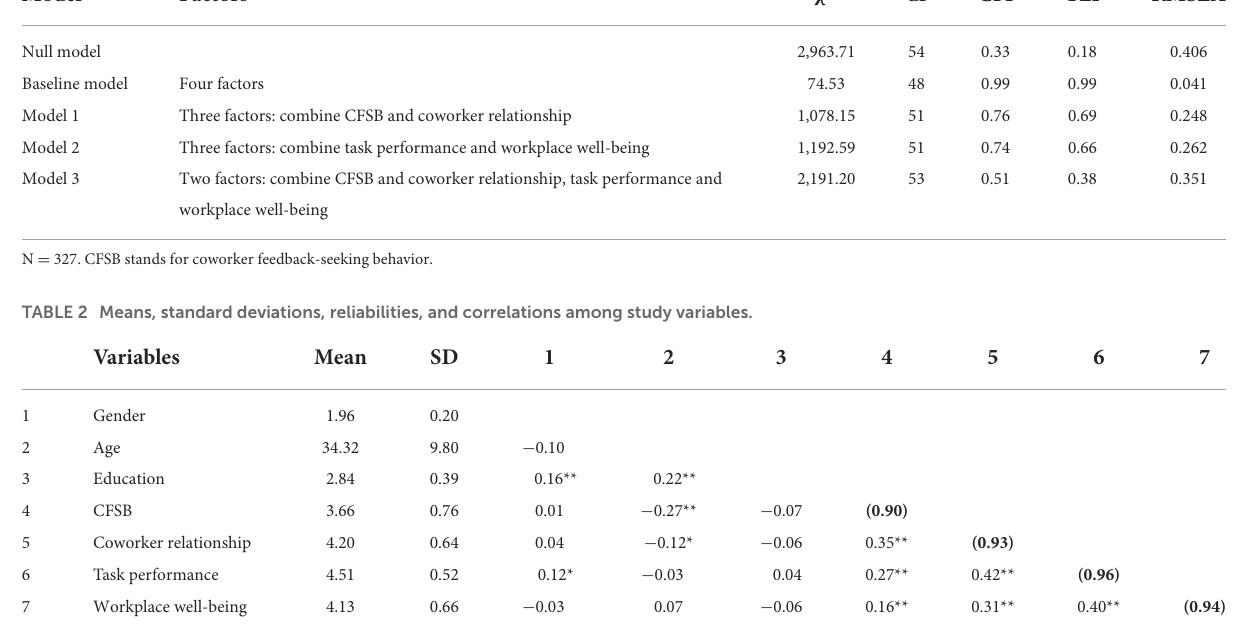
TABLE 1 Results of confirmatory factor analysis. Model